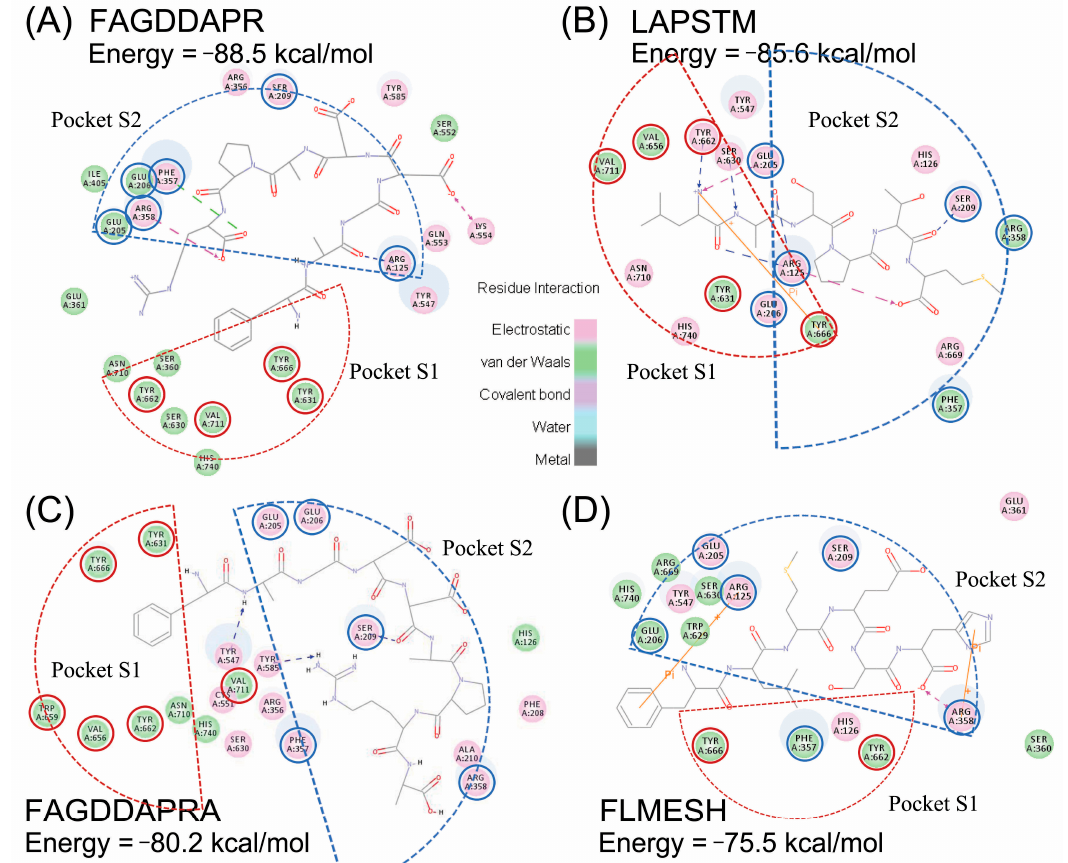
Figure 5. The binding model of peptide inhibitors to DPP-IV in docking studies. Best docking position of peptides FAGDDAPR ( A ); LAPSTM ( B ); FAGDDAPRA ( C ); and FLMESH ( D ) at the DPP-IV pocket. Red circles represent the amino acid residues belong to Pocket S1, and blue circles represent the amino acid residues belong to Pocket S2.